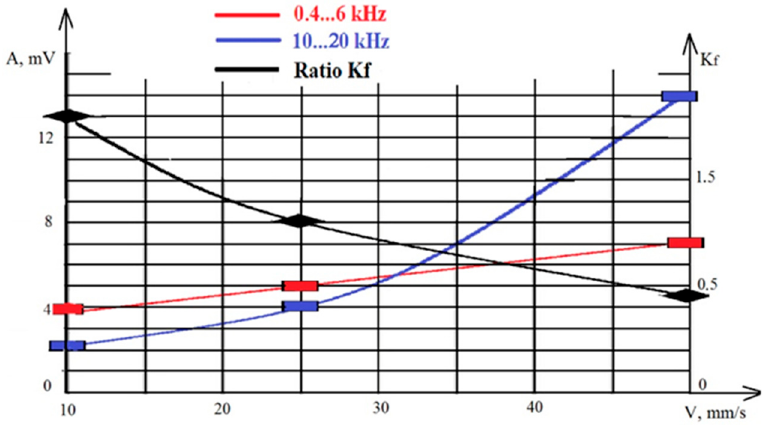
Figure 11. The changes in the effective amplitude of the VA signal in the frequency bands of 0.4–6 kHz (red), 10–20 kHz (blue), and their ratio K f (black) with changes in the speed (V) of the laser beam.